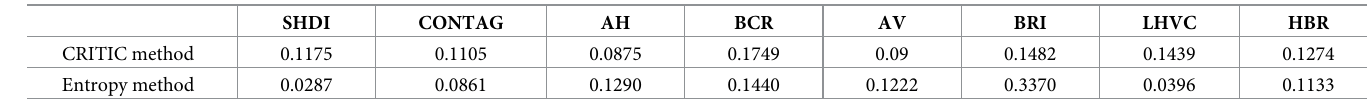
Table 3. Weighting values of the eight architectural landscape pattern indices.